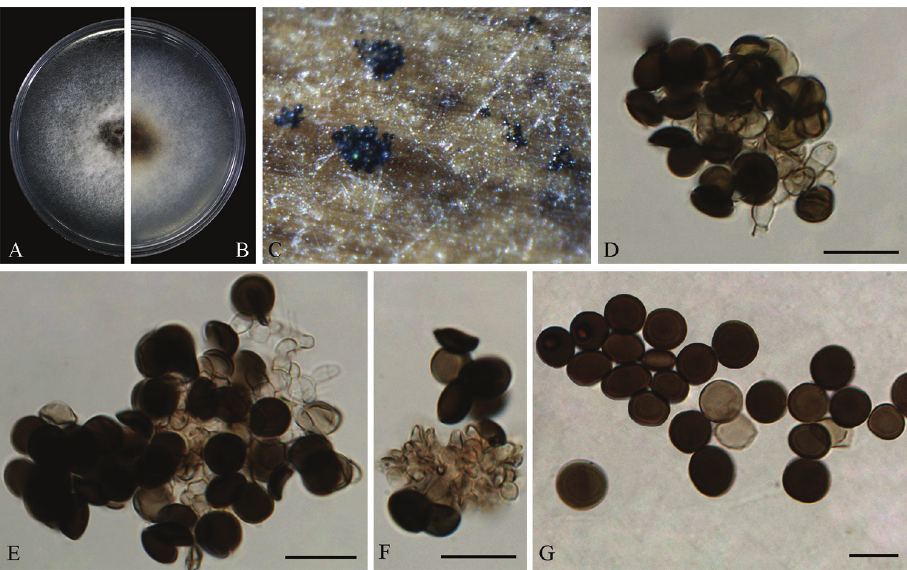
Figure 4. Arthrinium camelliae-sinensis (from ex-holotype strain CGMCC 3.18333) A–B 7 d old cultures on PDA C Colony on MEA with bamboo leaves producing conidia masses D–F Conidiogenous cells giv- ing rise to conidia G Conidia. Scale bars = 10 µm.